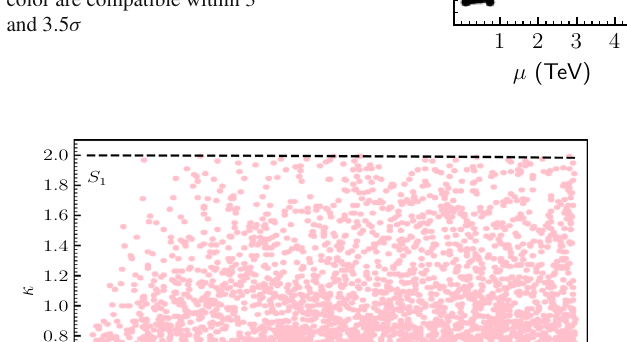
Fig. 3 Analysis of a SUSY μ in the tan β − μ plane for scans S 1 , 2 , 3 . The light-brown color corresponds to points of the parameter space fulfilling Higgs physics compatible at 2 σ with (cid:9) a μ . Brown color corresponds to compatibility between 2 and 3 σ , whereas points with black color are compatible within 3 and 3 . 5 σ